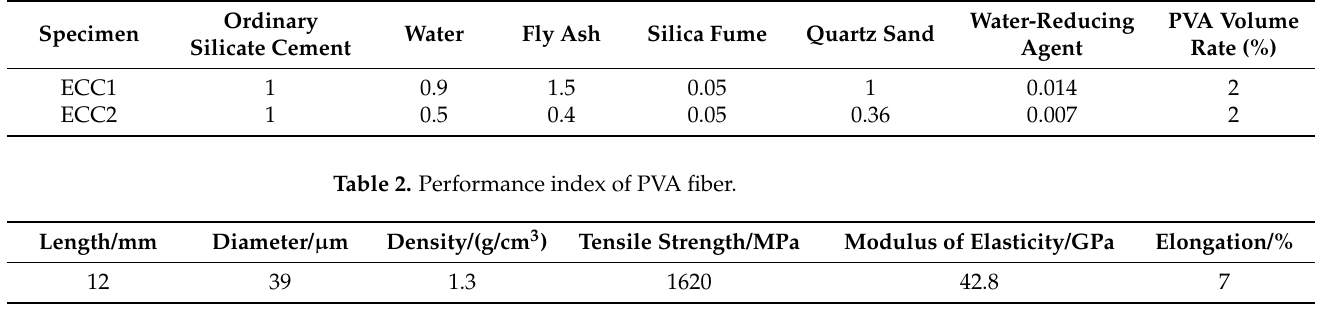
Table 1. ECC mix ratio (quality ratio).